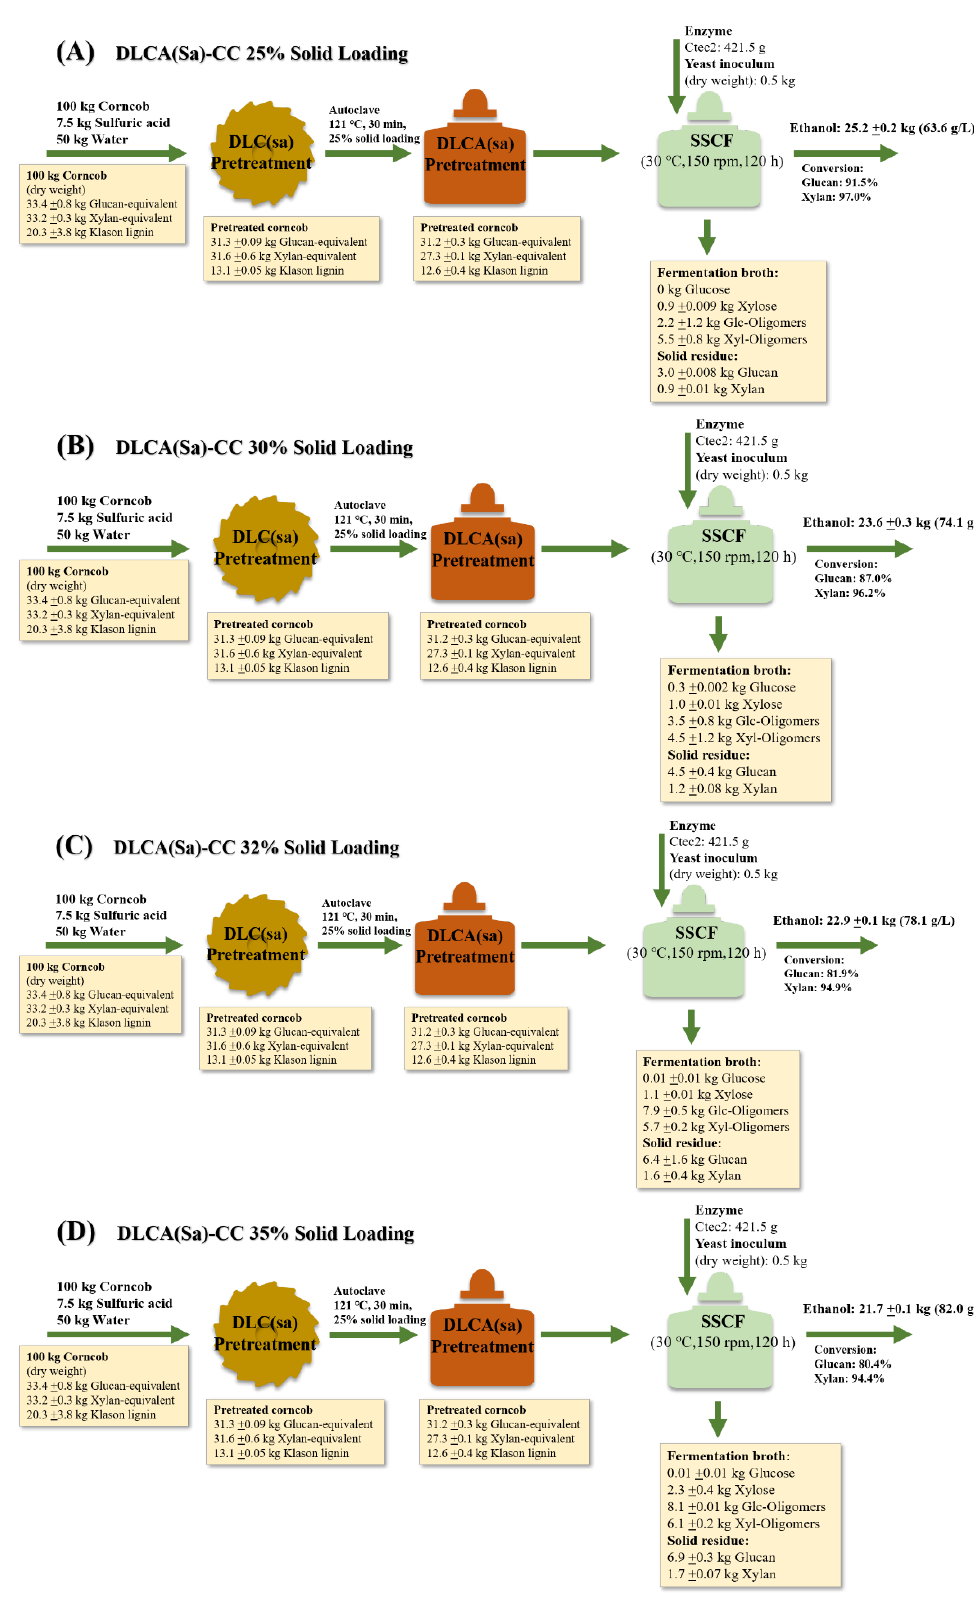
Figure 7. Mass balances of SSCF on DLCA(sa)-CC at different solids loadings. ( A ): 25% solid loading; ( B ): 30% solid loading; ( C ): 32% solid loading; ( D ): 35% solid